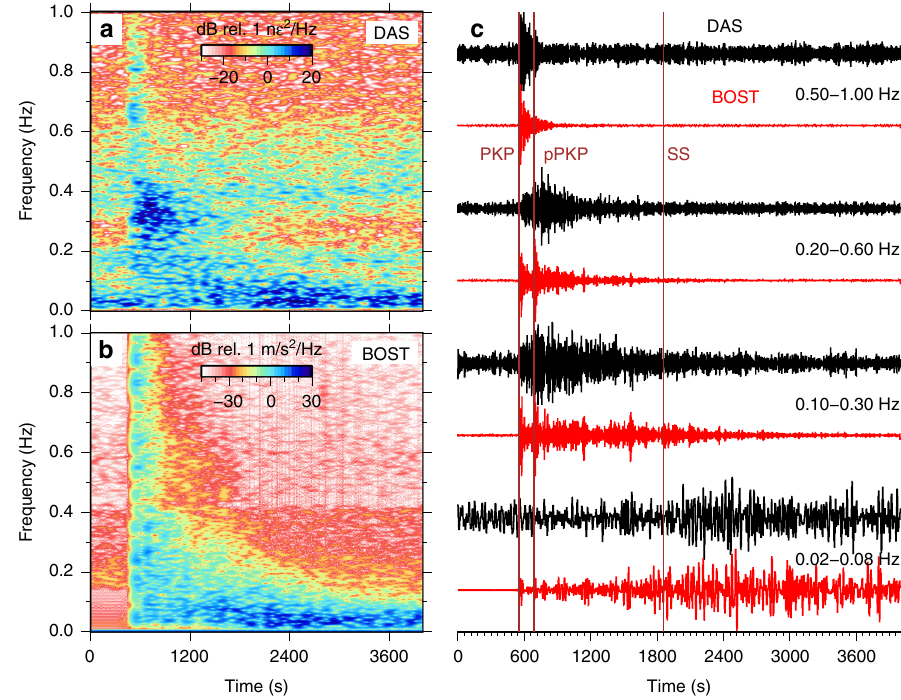
Fig. 9 Teleseismic waveforms. a Spectrogram of power spectral density (PSD) over time for the f - k fi ltered and stacked distributed acoustic sensing (DAS) beam trace (black in c ), showing strong energy between 0 and 1 Hz around the arrival of the PKP phase around 550 s and <0.1 Hz following the arrival of the SS phase around 1860 s. b Spectrogram for the rotated BOST channel (red in c ), showing the same major features. c Stacked DAS beam trace (black) fi ltered to various bands between 0.02 and 1 Hz compared with amplitude-normalized particle velocity from broadband station BOST rotated into the mean azimuth of the DAS array